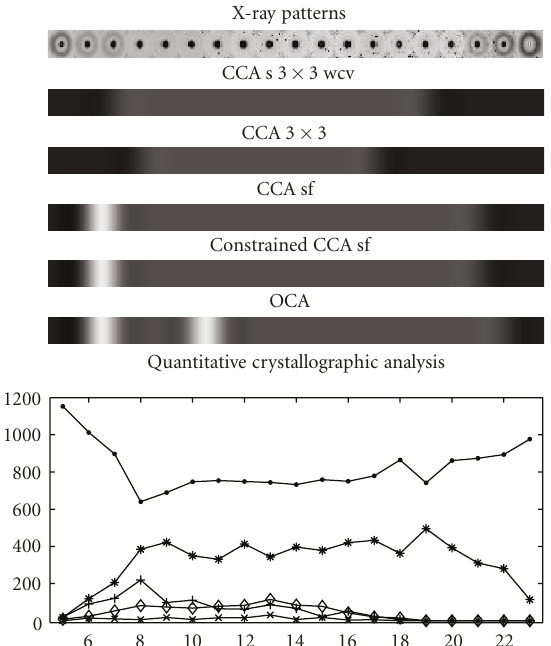
Figure 7: Top: cross-section from left to right of Figure 1 along the 9th row from top. Middle: the corresponding cross-sections of the di ff erent CCA maps of Figure 5 (black: amorphous, light gray: hy- droxya (micro), dark gray: hydroxya (nano)). Bottom: quantitative crystallographic analysis ( • : amorphous, ∗ : hydroxya (nano), (cid:2) : hydroxya (micro), × : Tcp( β ), +: Tcp( α